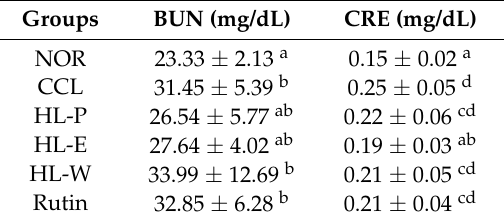
Table 5. The effects of red quinoa and its extracts on serum BUN and CRE of the CCl 4 -induced liver injury mice.